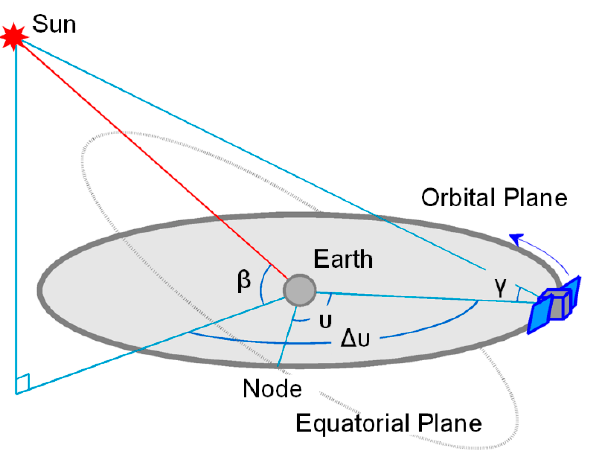
Figure 5. Schematic diagram of the satellite–Earth–Sun geometry and corresponding angular argu- ments.